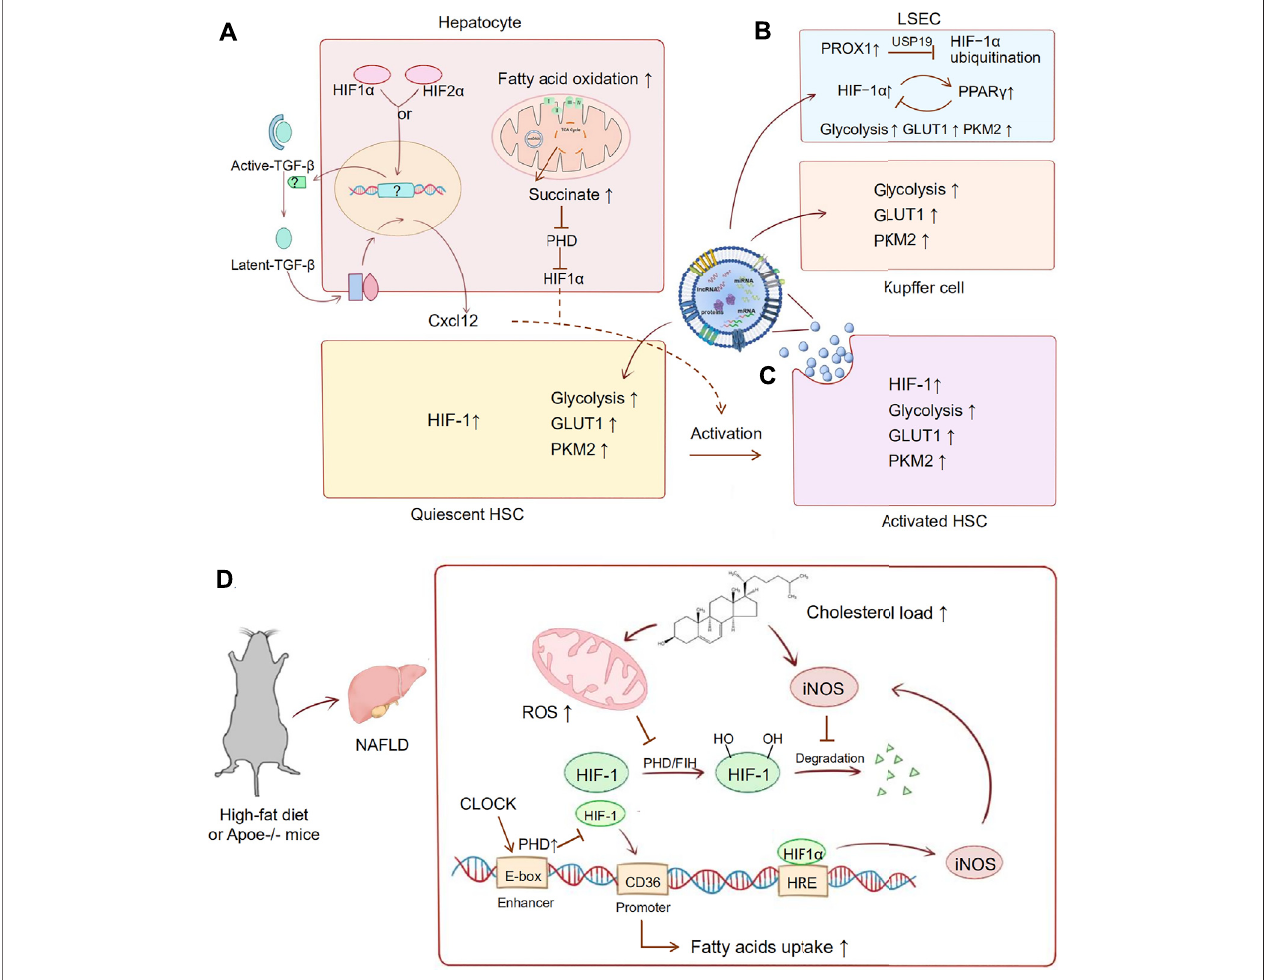
FIGURE 1 | HIF pathway applied in liver fi brosis. During the development of liver fi brosis, oxygen mediated metabolic reprogramming occurs in a variety of cells. Abnormal lipid metabolism and activation of HIF in hepatocytes mediate the fi brotic pathway and the activation of HSC cells. Besides, activated HSCs occur in intracellular metabolic reprogramming, and they also mediate the metabolic transformation of other parenchymal cells. (A) In hepatocytes, activated HIF-1 α or HIF-2 α stimulates upregulation of Cxcl12 through converting latent TGF- β to active TGF- β . Succinate accumulates in hepatocytes due to enhanced fatty acid oxidation, whichstabilizedand activated HIF-1 α throughimpairingPHDs.Expression ofCxcl12and HIF-1 α isinvolvedinactivationofHSCs. (B) InLSECs,PROX1inhibites HIF-1 α ubiquitination via adeubiquitinase called USP19. A possible loop shows that HIF-1 α induces PPAR γ expression as a hypoxicresponse, then overexpressed PPAR γ will inhibit HIF-1 α transcription hypoxia as a negative feedback. (C) In activated HSCs, HIF-1 upregulates the GLUT1 and PKM2 expression in exosomes. Then these exosomes are absorbed by KCs, LSECs, and quiescent HSCs, which enhanced glycolysis of these nonparenchymal cells. (D) High-fat diet and Apoe knockout are common modeling methods of NAFLD. HIF-1 is also involved in metabolic disorder in the development of NAFLD to liver fi brosis. In this process, cholesterol load increased mitochondrial dysfunction and iNOS levels, which promoted HIF-1 stabilization and transcriptional activity. Then, the abnormal activation of HIF-1 promoted the production ofiNOS and formed a malignantloop for fi brosis. Furthermore, HIF-1 is also involved in the circadian locomotor-related metabolic disorders in NAFLD. In CLOCK de fi ciency, HIF1 α binds to the Cd36 promoter, promoting CD36 expression and uptake of fatty acids in the liver. High fat feeding and AP knockout mice are common modeling methods of